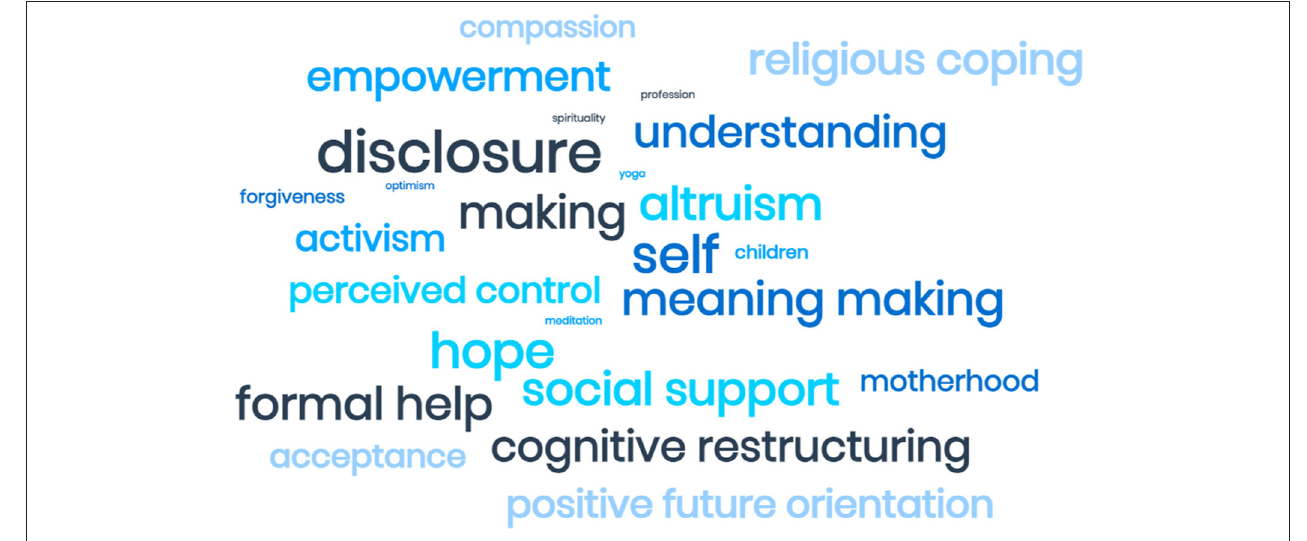
FIGURE 2 | Visualization of